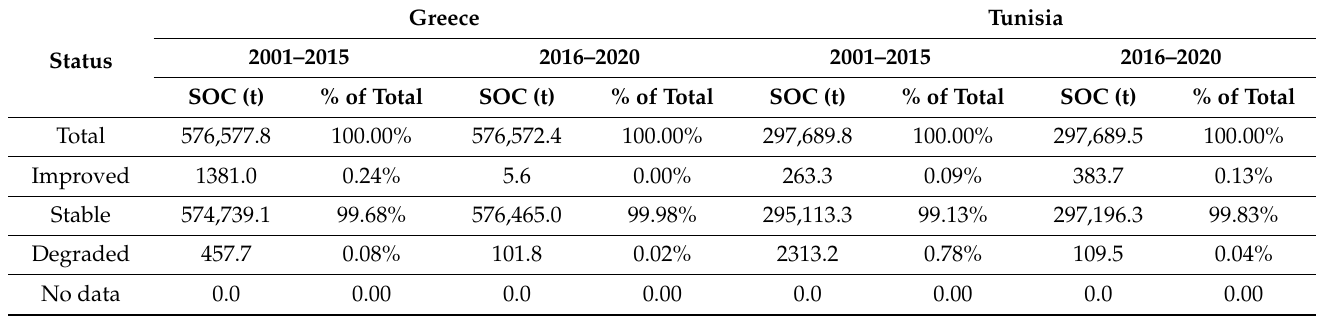
Table 6. Soil organic carbon metrics for the baseline and reporting periods in Greece and